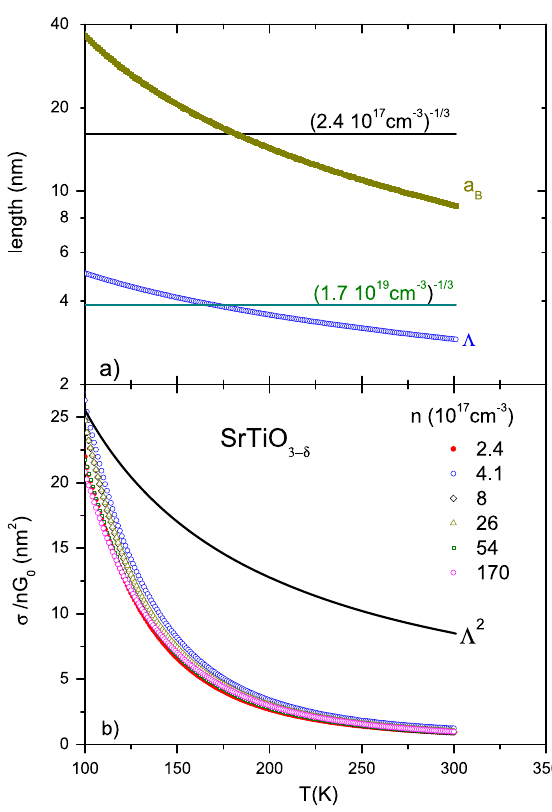
Fig. 5 Length scales and transmission. a Temperature dependence of different length scales at two different carrier densities. The de Broglie thermal wavelength, Λ , was calculated assuming an effective mass of m * = 1.8m e , found by quantum oscillations at low temperature. The effective Bohr radius was calculated using this mass and the permittivity data reported in. 36 b Transmission coef fi cient extracted from resistivity data for different carrier concentrations compared to Λ 2